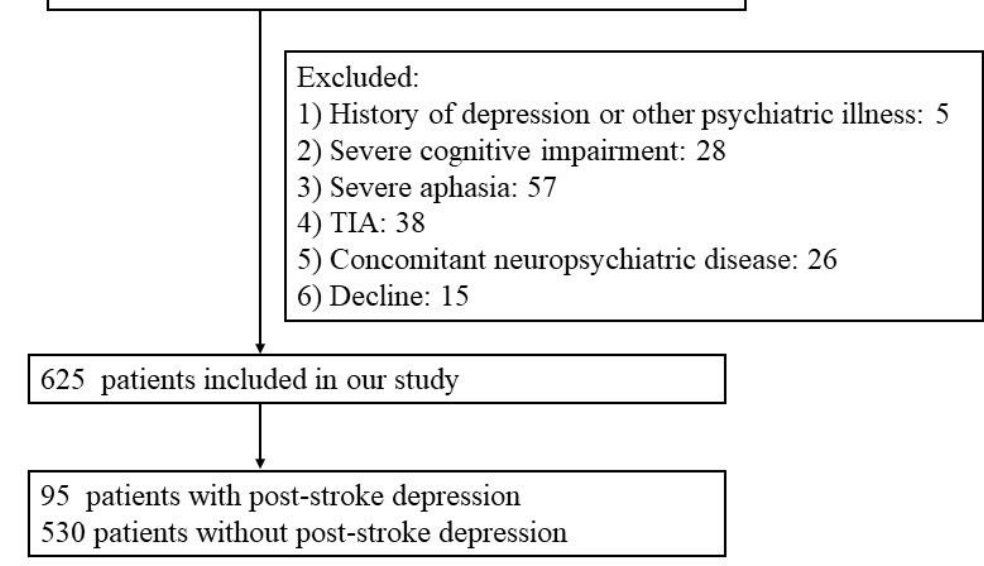
Figure 1. Flow chart. Flow diagram of included and excluded patients. Table 1. Baseline characteristics of the study.